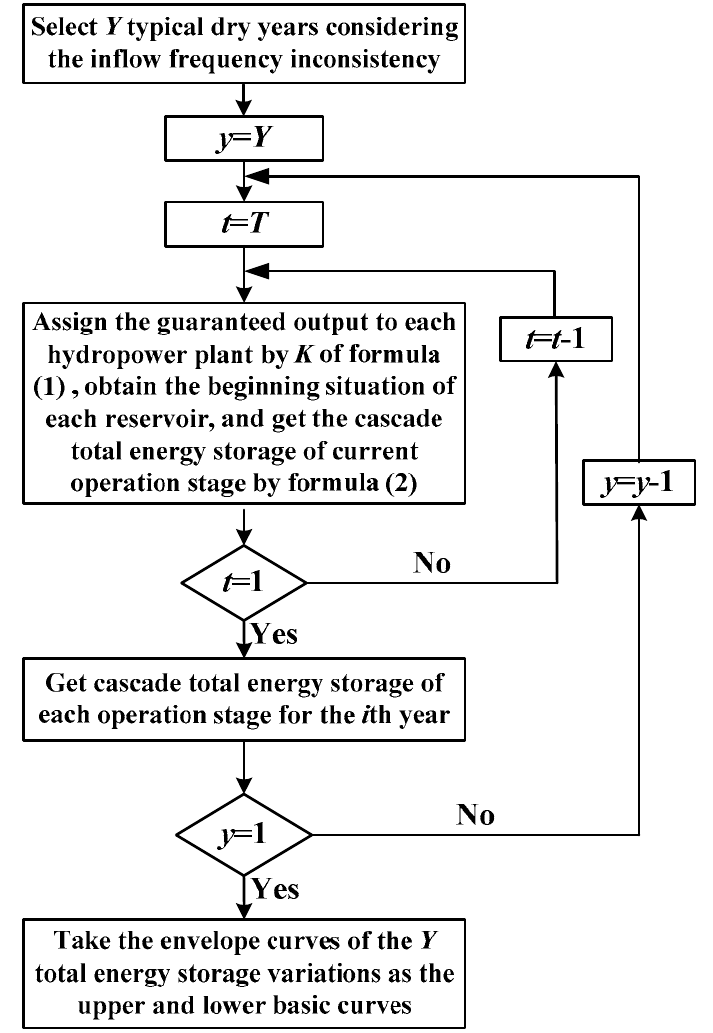
Figure 1. Inverse calculation process of drawing basic operation curves.